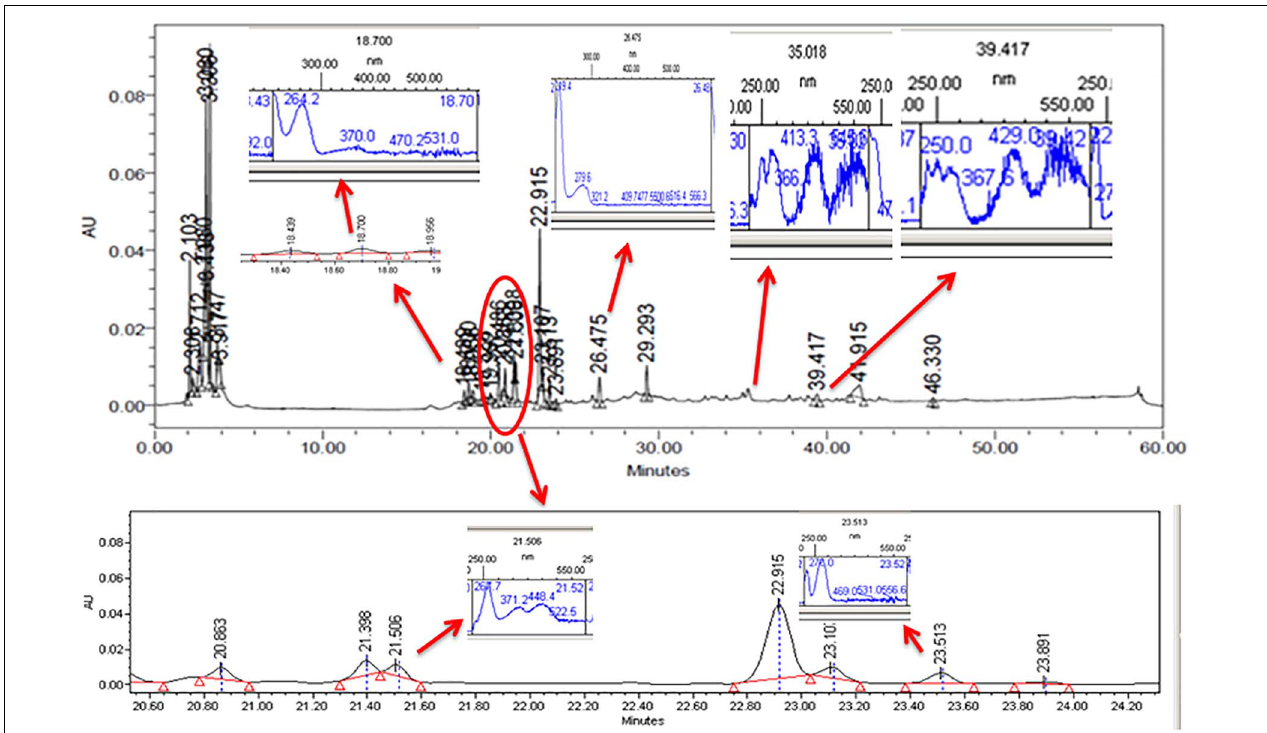
FIGURE 6 | High-performance liquid chromatography–diode array detector chromatogram of the CPEF04 mycelium filtrate. The presence of UV–visible having λ max absorption in the range of 412–430 and 514–546 further suggests the presence of Monascus -like azaphilone